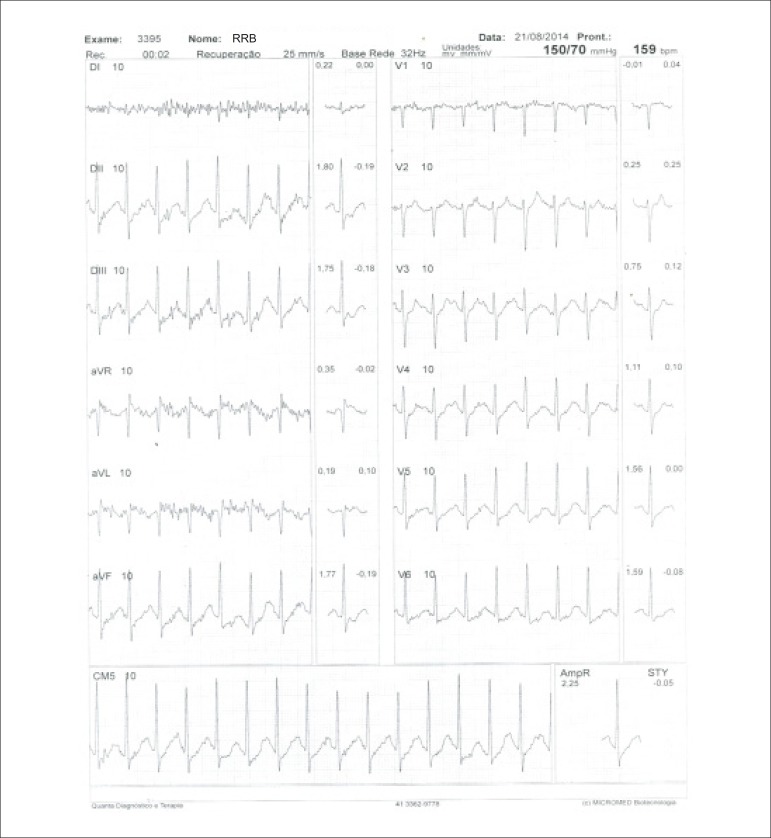
Case 9 - Electrocardiogram tracing obtained during immediate recovery period, with no significant alterations.